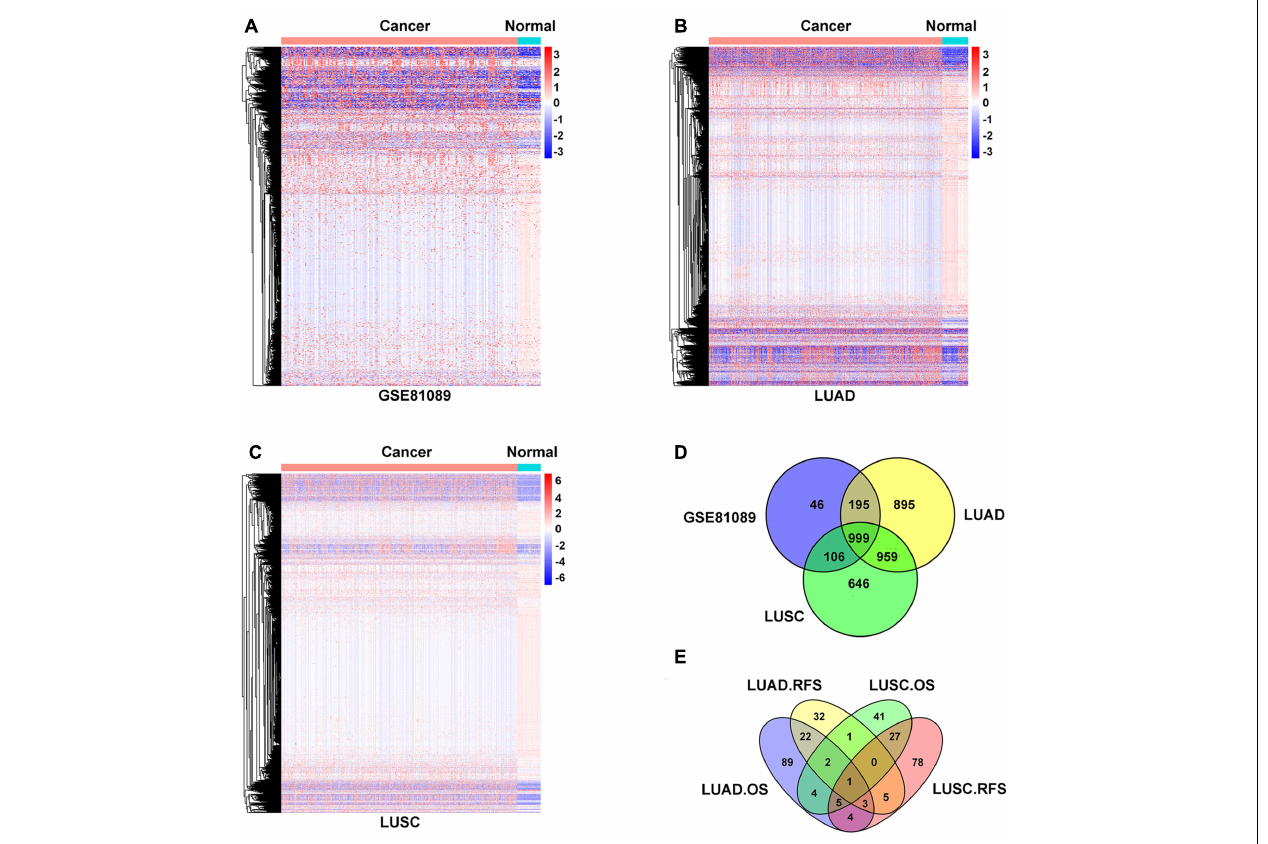
FIGURE 1 | Identification of differentially expressed oncogenic lncRNAs in NSCLC. (A–C) Hierarchical clustering heat map of the upregulated lncRNAs of NSCLC samples compared with normal lung samples from TCGA (LUAD and LUSC) and GSE81089, with absolute fold changes > 1.5 and p -value < 0.05 as significant. (D) Venn diagram of the intersection of lncRNAs upregulated in TCGA (LUAD and LUSC) and GSE81089 databases. (E) Venn diagram of the intersection of OS and RFS in survival analysis of LUAD and LUSC patients expressing LINC02678 based on the TCGA database.